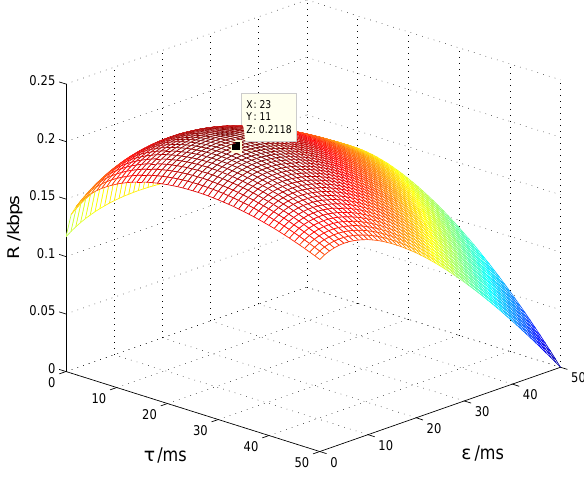
Figure 8. Transmission rate with spectrum sensing time and energy harvesting